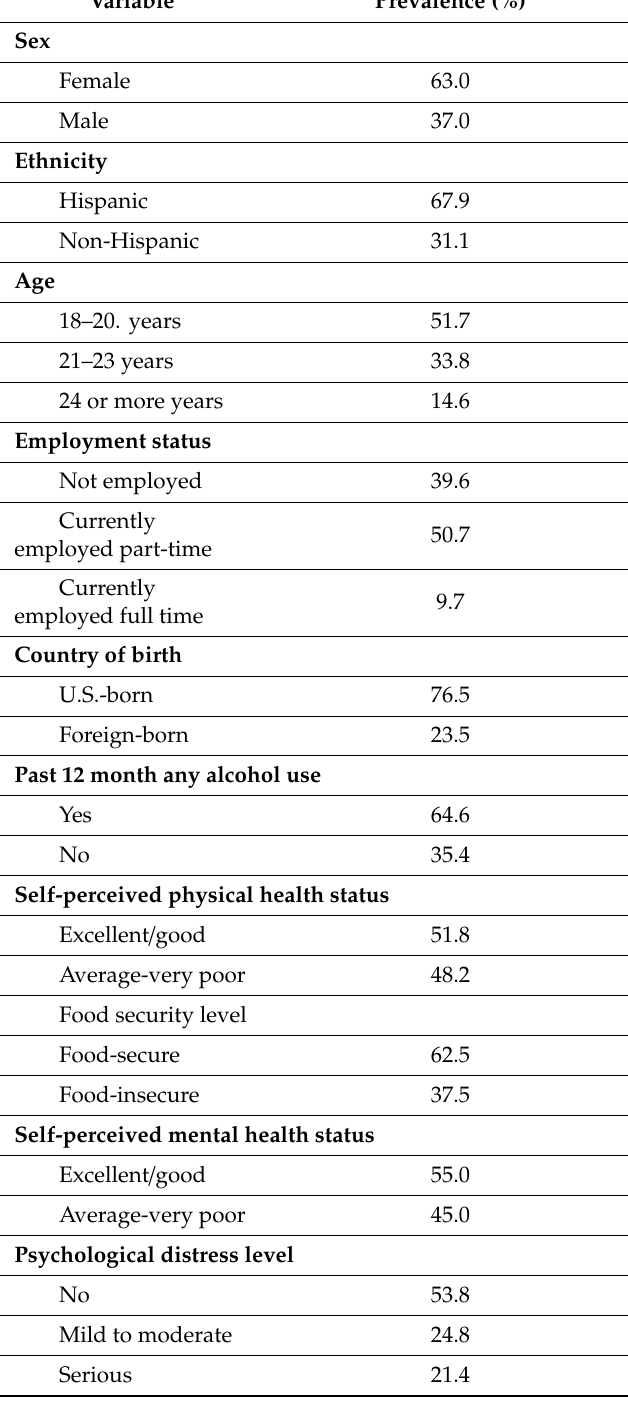
Table 1. Characteristics of the study participants, n =